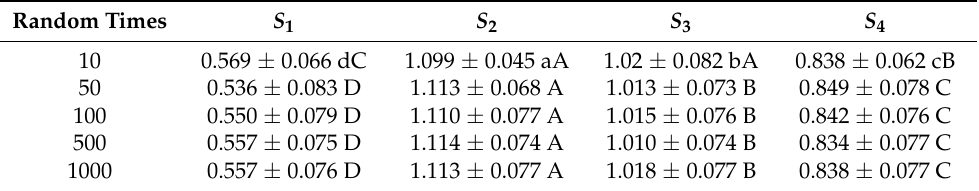
Table 6. Results of statistical characters and significance analysis.